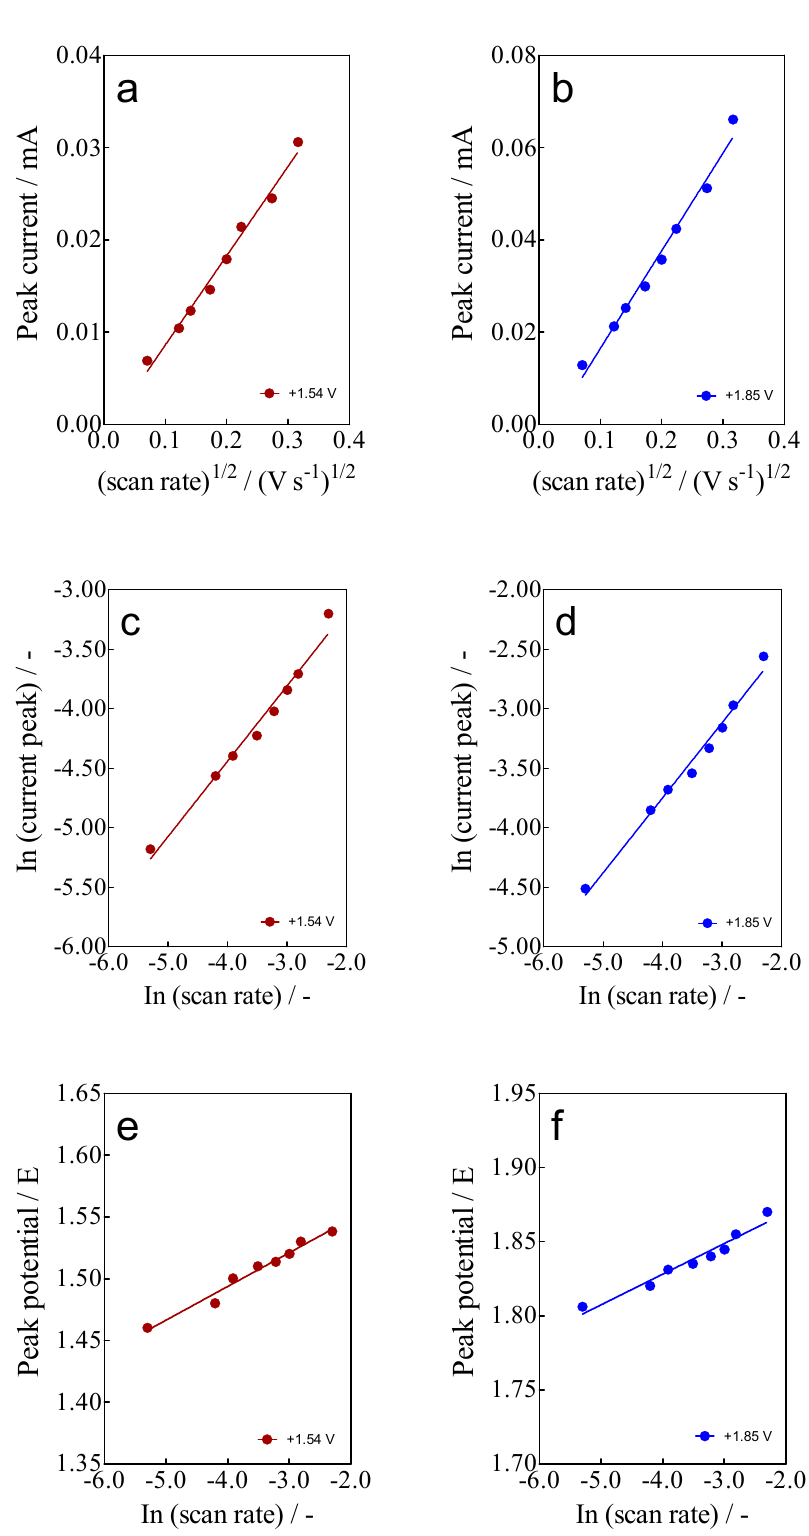
Figure 5. Linear dependence of the i p at E pa 3 (+1.54 V) and E pa 4 (+1.85 V) with: ( a , b ) square root ( ν 1/2 ), ( c , d ) scan rate ( ν ) of potential (as ln both), and ( e , f ) peak potential E pa 3 (+1.54 V) and E pa 4 (+1.85 V) on the ln ν (V s − 1 ) for the Calcon dye (100 mg L − 1 ) in 0.25 M H 2 SO 4 at the BDD electrode.